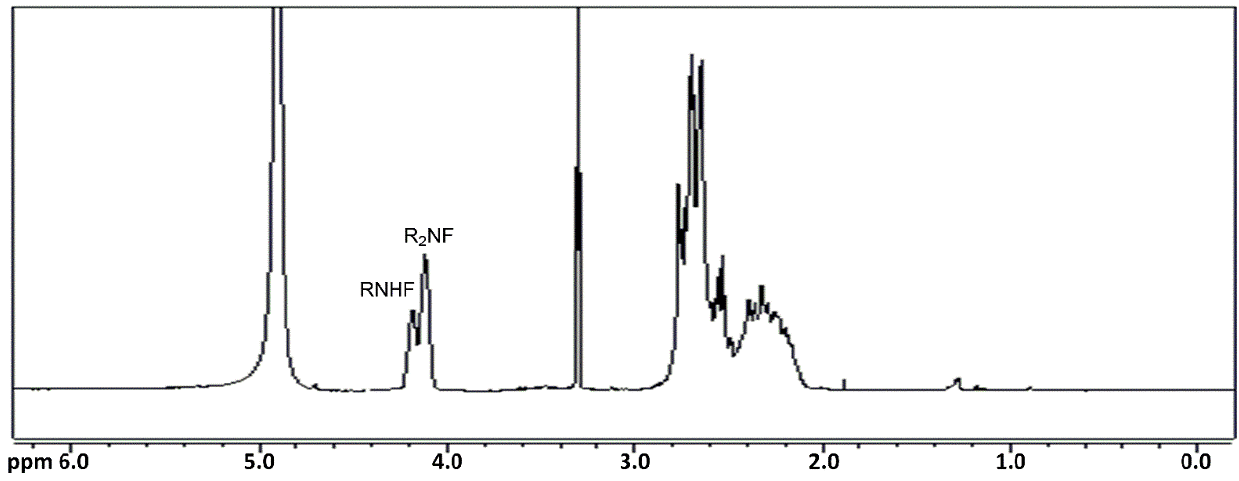
Figure 5. 1 H NMR spectrum in CD 3 OD of oligoamide DF.